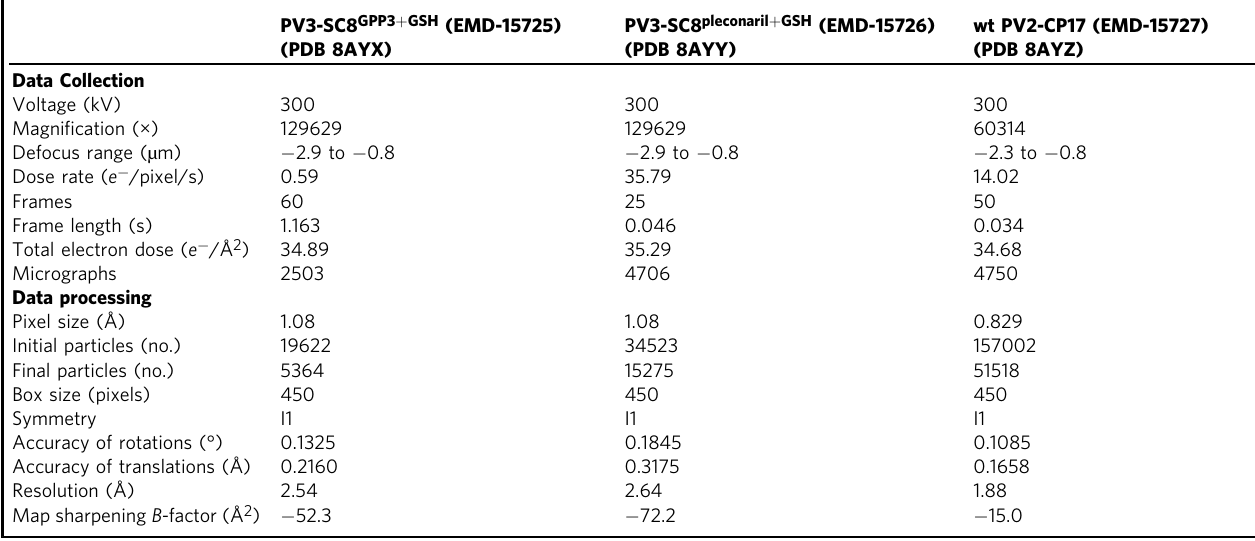
Table 1 Cryo-EM data collection and image processing.